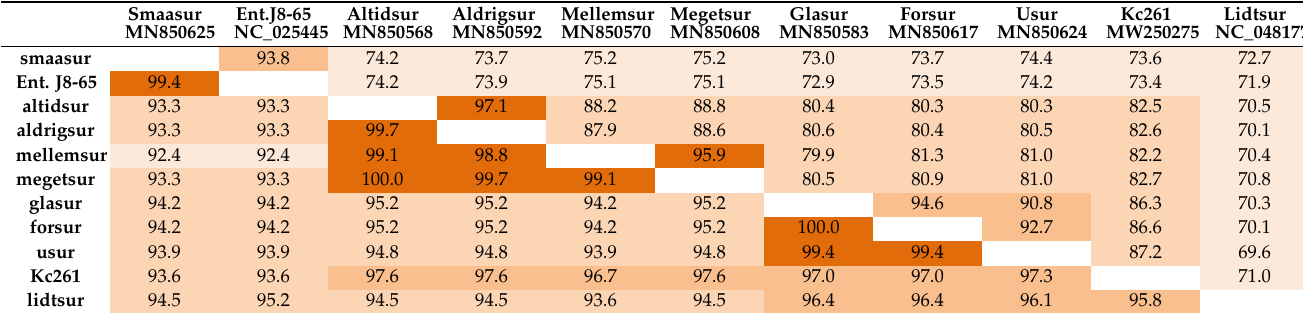
Table 2. Genome nucleotide sequence percentage identities of bonnellviruses (above diagonal), and major capsid protein (mCP) aa sequence identities (below